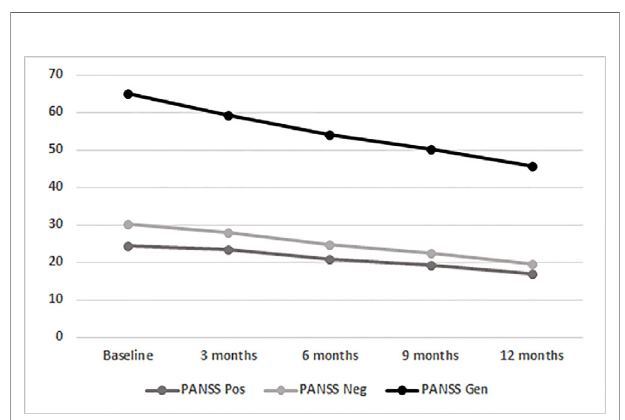
FIGURE 1 | Time course of total PANSS scores in the entire population (BL, baseline; mo, months; PANSS, Positive And Negative Syndrome Scale; Gen, General Psychopathology scale; Neg, Negative scale; Pos, Positive Scale).